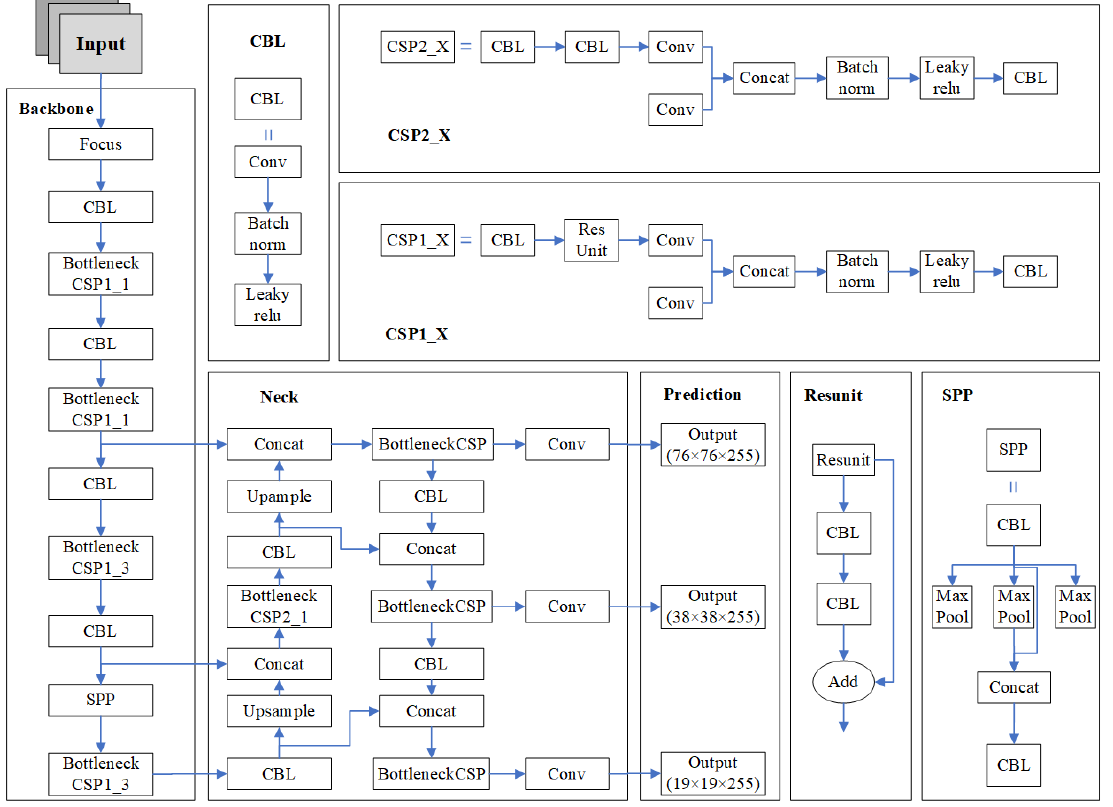
Figure 3. YOLOv5s network structure.